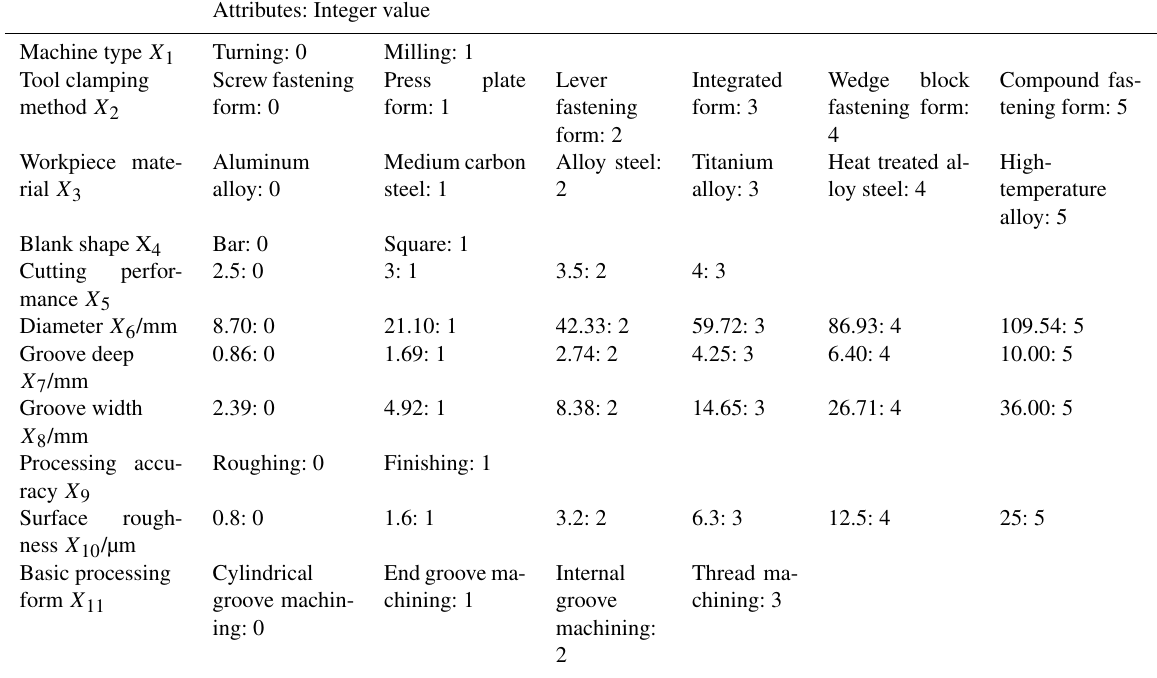
Table B1. Representation of scene